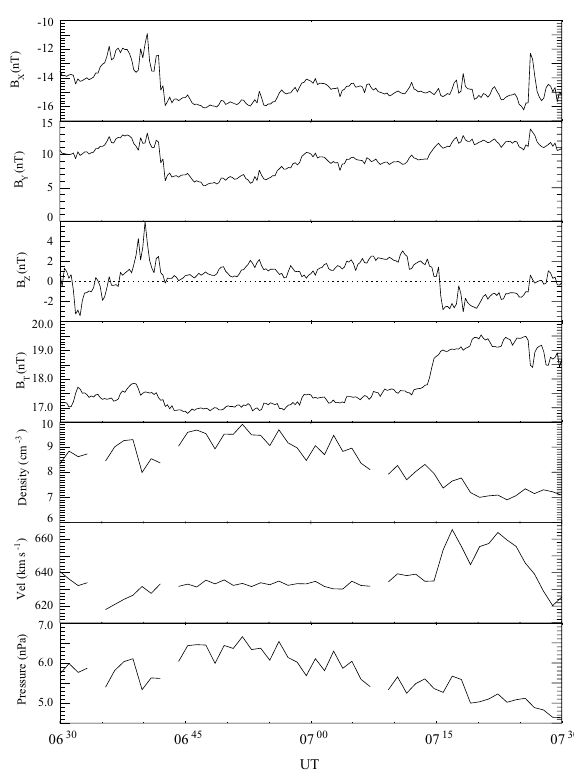
Fig. 2 Fig. 2. Solar wind and IMF data obtained by the ACE spacecraft for